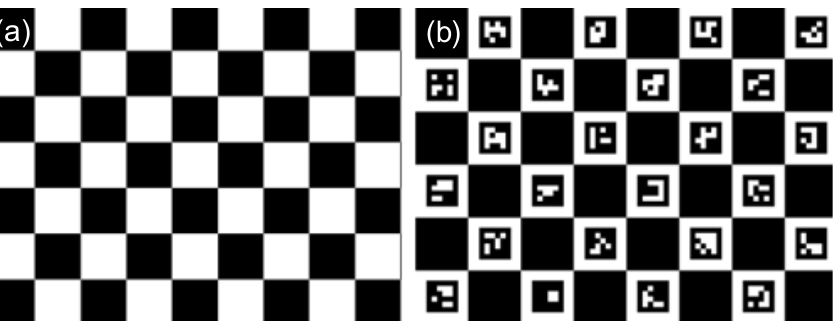
Figure 8. Checkerboard patterns ( a ) and symbols ( b ) are used to help the process of identifying homologous points between the photographs and the scale of the three-dimensional reconstructed object. Source: OpenCV Documentation [42].